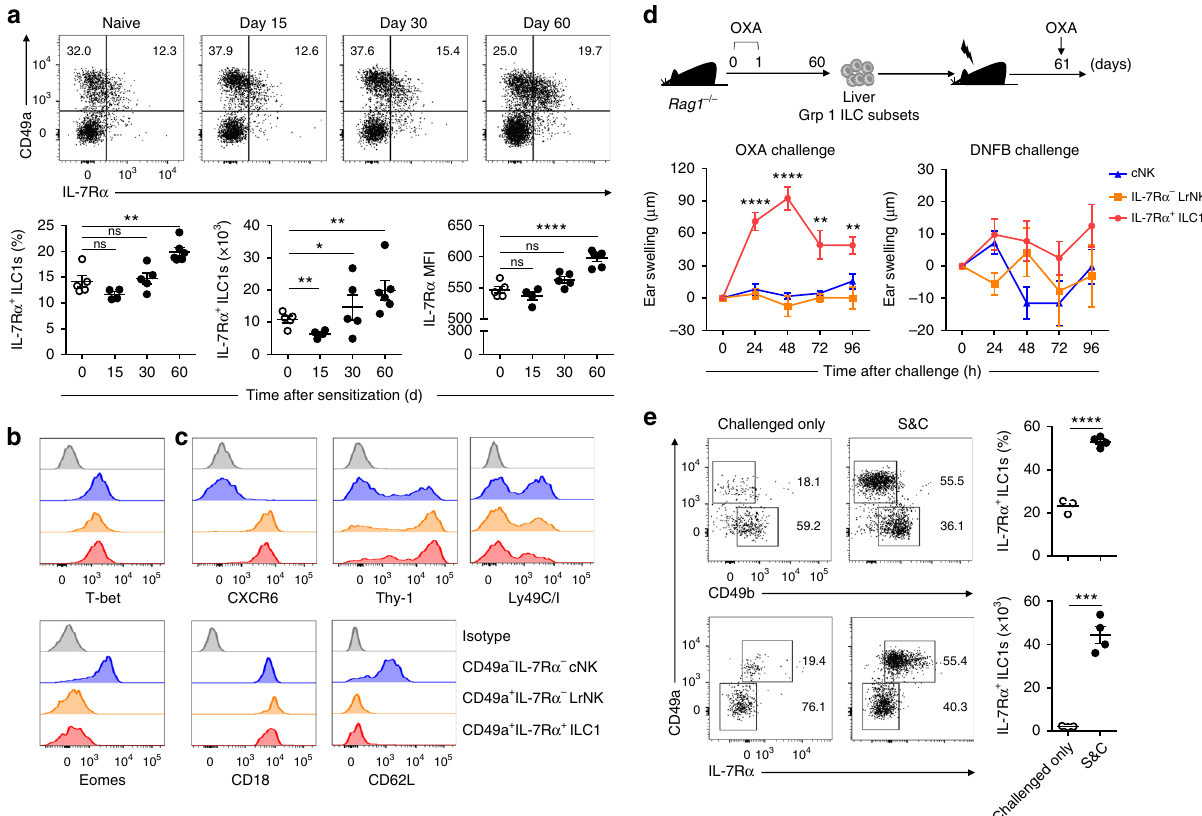
Fig. 1 Liver IL-7R α + ILC1s confer hapten-speci fi c CHS responses. a Representative dot plots (top panels) showing CD49a and IL-7R α expression on liver CD3 − NK1.1 + NKp46 + cells at different time points after OXA sensitization in WT C57BL/6 (B6) mice. Statistical analysis of results (bottom panels) showing the percentages and absolute numbers of liver IL-7R α + ILC1s and mean fl uorescent intensity (MFI) of IL-7R α on liver ILC1s. Liver ILC1s were gated on CD3 − NK1.1 + NKp46 + CD49a + IL-7R α + . Data are representative of two independent experiments ( n = 4 – 6 in each group). b , c Expression of the indicated transcription factors ( b ) or cell surface markers ( c ) by liver cNK cells (CD3 − NK1.1 + NKp46 + CD49a − IL-7R α − ), IL-7R α − LrNK cells (CD3 − NK1.1 + NKp46 + CD49a + IL-7R α − ), and IL-7R α + ILC1s (CD3 − NK1.1 + NKp46 + CD49a + IL-7R α + ) from OXA-sensitized (day 60) WT B6 mice. Data are representative of at least three independent experiments ( n = 3 – 5 in each experiment). d Ear swelling of WT B6 mice that received 5 × 10 4 liver cNK cells, IL-7R α − LrNK cells, or IL-7R α + ILC1s from OXA-sensitized Rag1 − / − donors, followed by ear skin challenge with OXA or DNFB. Data are representative of two independent experiments ( n = 4 – 5 in each group). e Representative dot plots (left panels) showing CD49a and IL-7R α expression on CD45 + NK1.1 + NKp46 + cells in ear skin from OXA-challenged naive (challenged only) or sensitized (S&C) Rag1 − / − mice. Statistical analysis of results (right panels) showing the percentages and absolute numbers of ear skin IL-7R α + ILC1s. Data are pooled from two independent experiments ( n = 3 – 4 in each group). Means ± SEM are shown. * P < 0.05, ** P < 0.01, *** P < 0.001, **** P < 0.0001, two-tailed unpaired Student ’ s t test ( a , e ) and unpaired one-way ANOVA ( d memory Ly49H + cNK cells 8,9 . In contrast, Ki67 expression in (Supplementary Fig. 2a – c). After skin sensitization with OXA, IL- 7R α + ILC1s in abdomen skin-draining LNs initially increased LN IL-7R α + ILC1s decreased slightly when cell numbers peaked both in frequency and in total number, with numbers peaking at in the CHS model (Fig. 3a and Supplementary Fig. 4a), suggesting that the increase of IL-7R α + ILC1s was not due to clonal expansion. During the contraction phase, LN IL-7R α + ILC1s did not exhibit increased apoptosis (7AAD + ) (Fig. 3b and Supple-